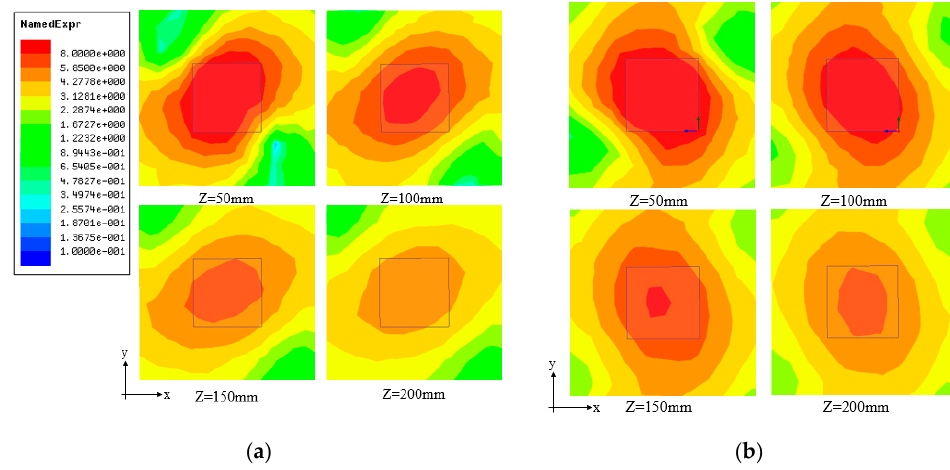
Figure 11. Distribution of simulated electric field components (Ex, Ey) at different heights with four spiral loops: ( a ) Ex distribution and ( b ) Ey distribution.